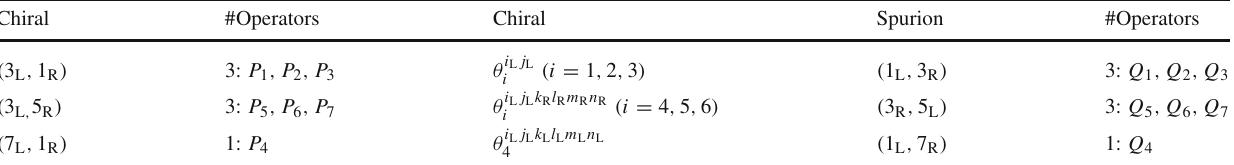
Table 1 The chiral representations of the dimension-9 six-quark operators as listed in [11] as well as the corresponding spurions. The indices on the spurions are SU ( 2 ) L × SU ( 2 ) R upper doublet, fully symmetrized in the indices of the same type Chiral #Operators Chiral Spurion